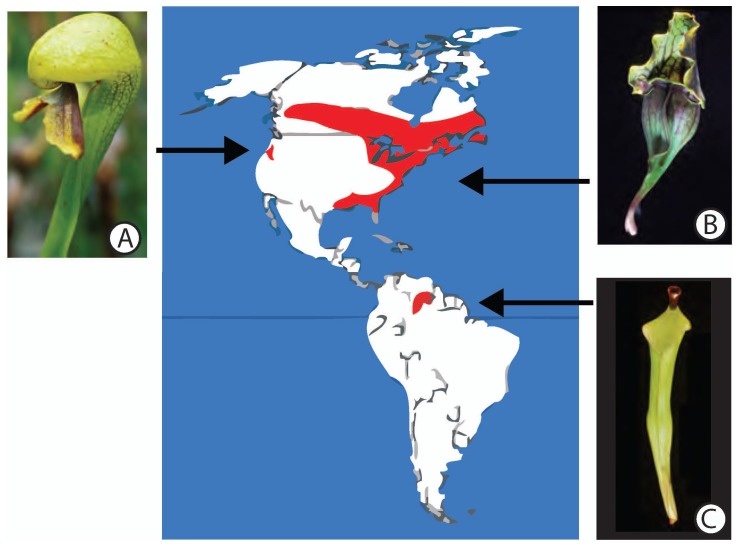
Geographic distribution of Sarraceniaceae.
Darlingtonia (A) is restricted to western North America, Sarracenia (B) is widespread in Eastern North America, and Heliamphora (C) occurs in northern South America [17], [27]. Photographs by the authors.